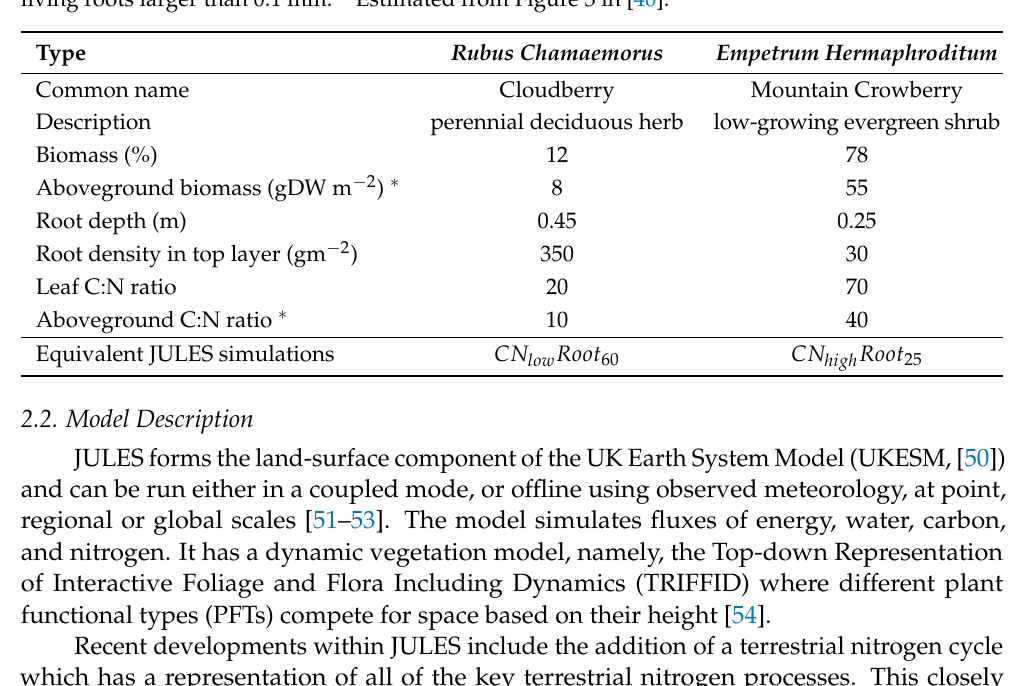
Table 1. Summary of the observed plant characteristics of the two dominant vegetation types observed in the plots. Root content was evaluated at a top soil layer depth of 15 cm and included all living roots larger than 0.1 mm. ∗ Estimated from Figure 3 in